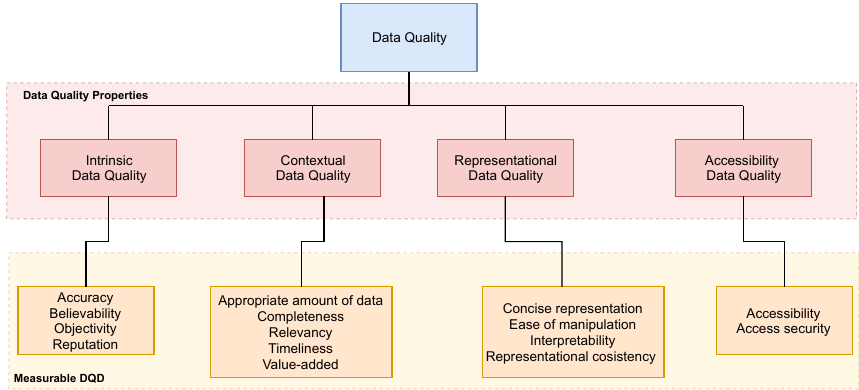
Figure 2. Data quality properties and the corresponding DQDs (Data Quality